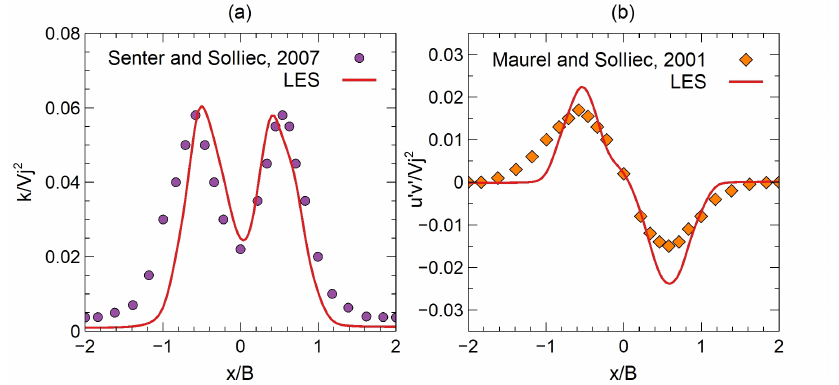
Figure 18. Normalized turbulent kinetic energy ( a ) and Reynolds stress ( b ) at y / B = 4, compared to reference results reported by Senter and Solliec [70] and Maurel and Solliec [81].